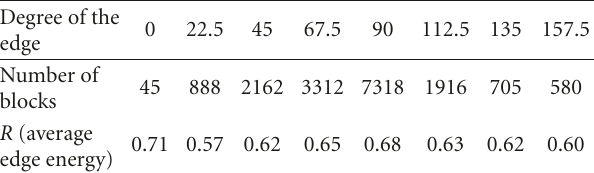
Table 1: The R values of the edge blocks in “Lena”. The angles of the edge blocks are classified to 8